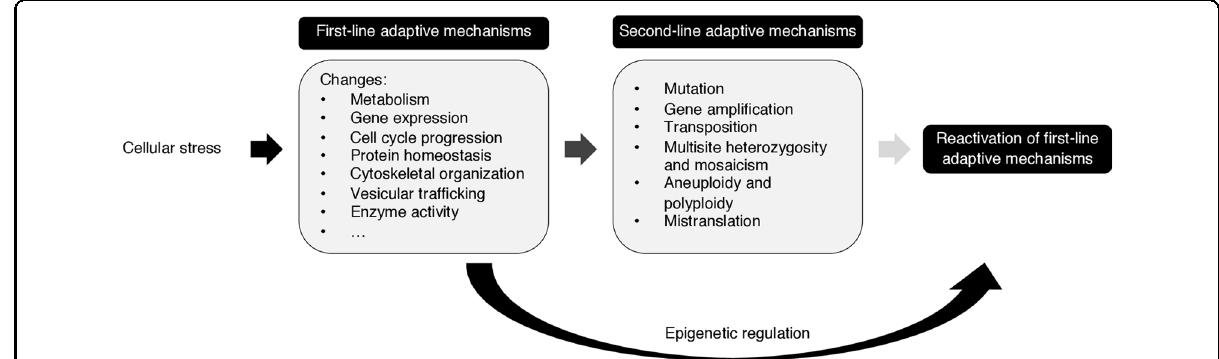
Fig. 1 Stress-induced cellular adaptive strategies. First-line adaptive mechanisms maximize cell survival under acute stress conditions. When these protective responses are not suf fi cient to protect cells from stress, the cells activate second-line adaptive mechanisms, which primarily consist of genetic changes that confer resistance to stress. However, because some second-line responses are deleterious to cell fi tness, they may evolve or reactivate other adaptive mechanisms through genetic or epigenetic